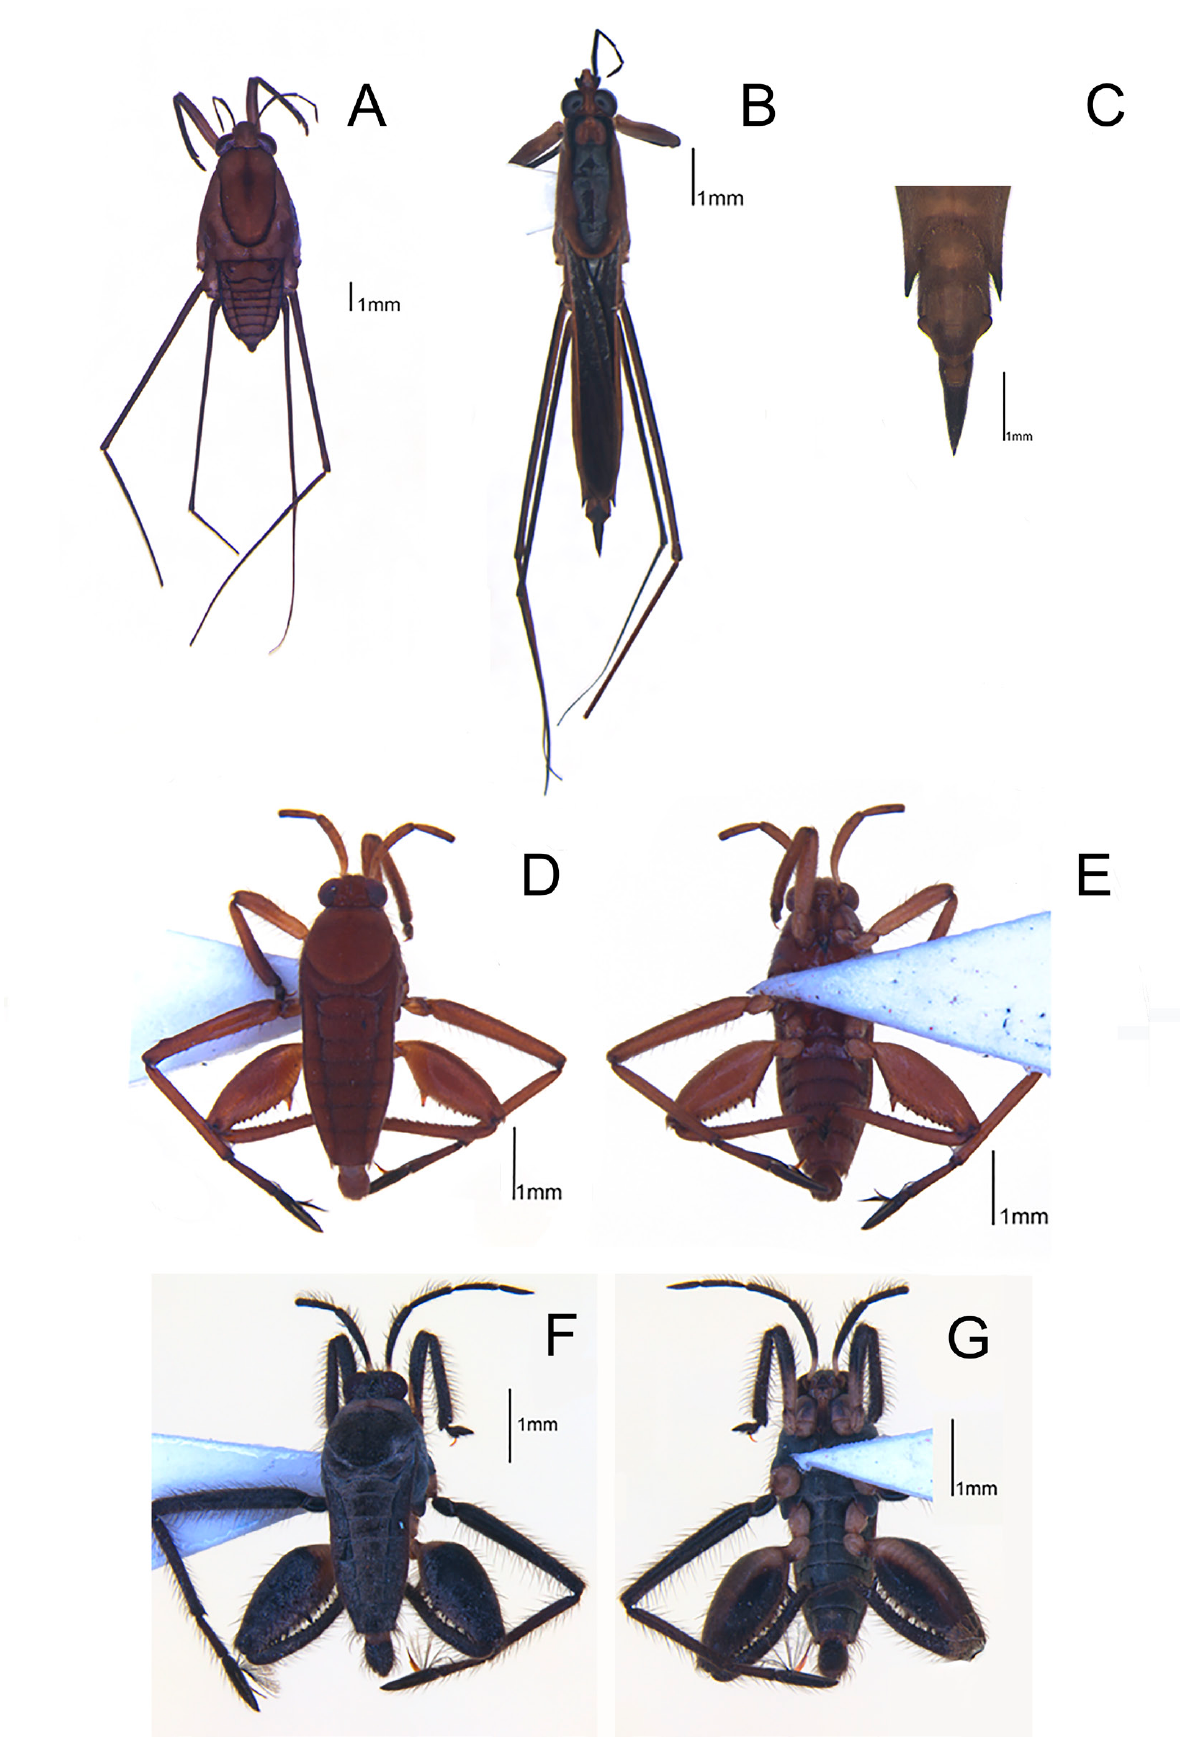
Figure 11. Specimens of semiaquatic bugs collected in Brazilian caves. A. Brachymetra albinervus , apterous female, habitus, dorsal view. B, C. Cylindrostethus palmaris , macropterous male. B. Habitus, dorsal view. C. Apex of abdomen, ventral view. D, E. Rhagovelia henryi , apterous male, habitus. D. Dorsal view. E. Ventral view. F, G. Rhagovelia robusta , apterous male, habitus. F. Dorsal view. G. Ventral